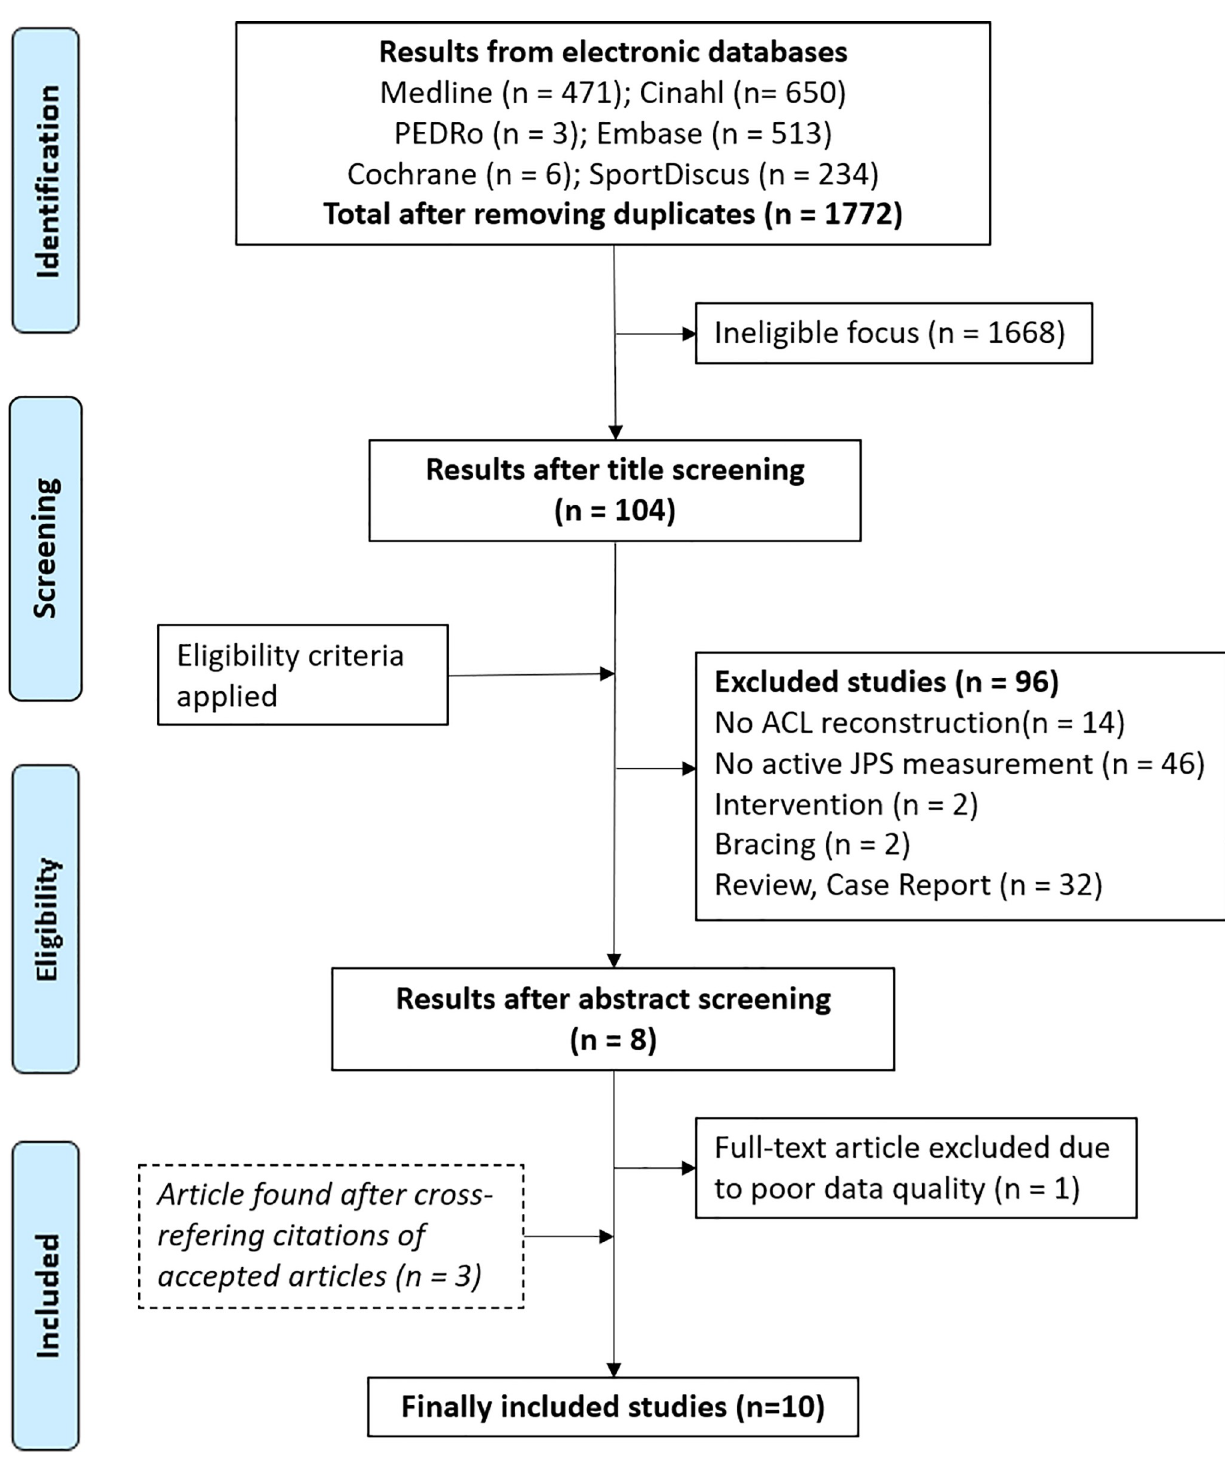
Fig 1. Flow diagram of the study selection process according to PRISMA [12]. Legend: ACL = Anterior cruciate ligament; JPS = joint position sense test.